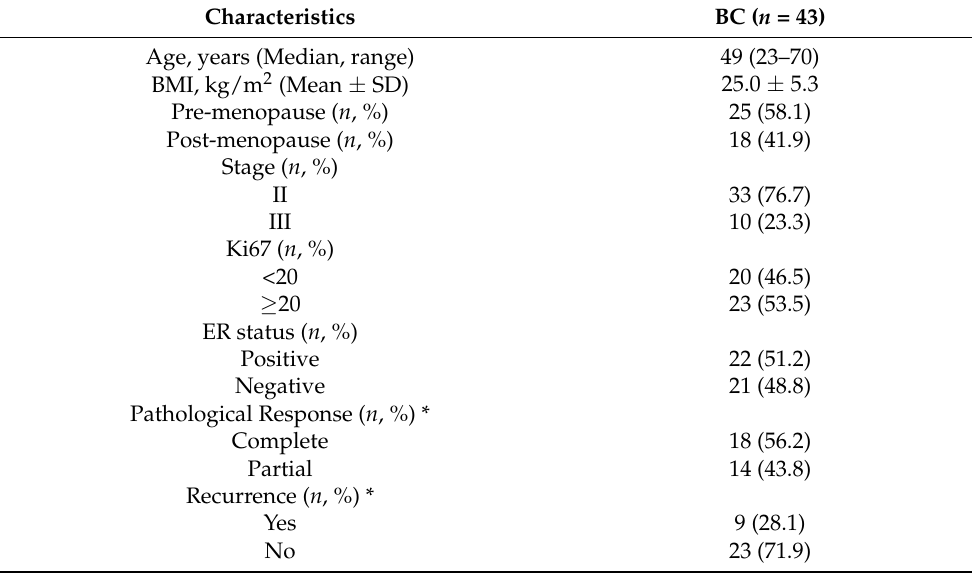
Table 1. Demographic and clinical characteristics of the HER2-positive BC patients and the CTR